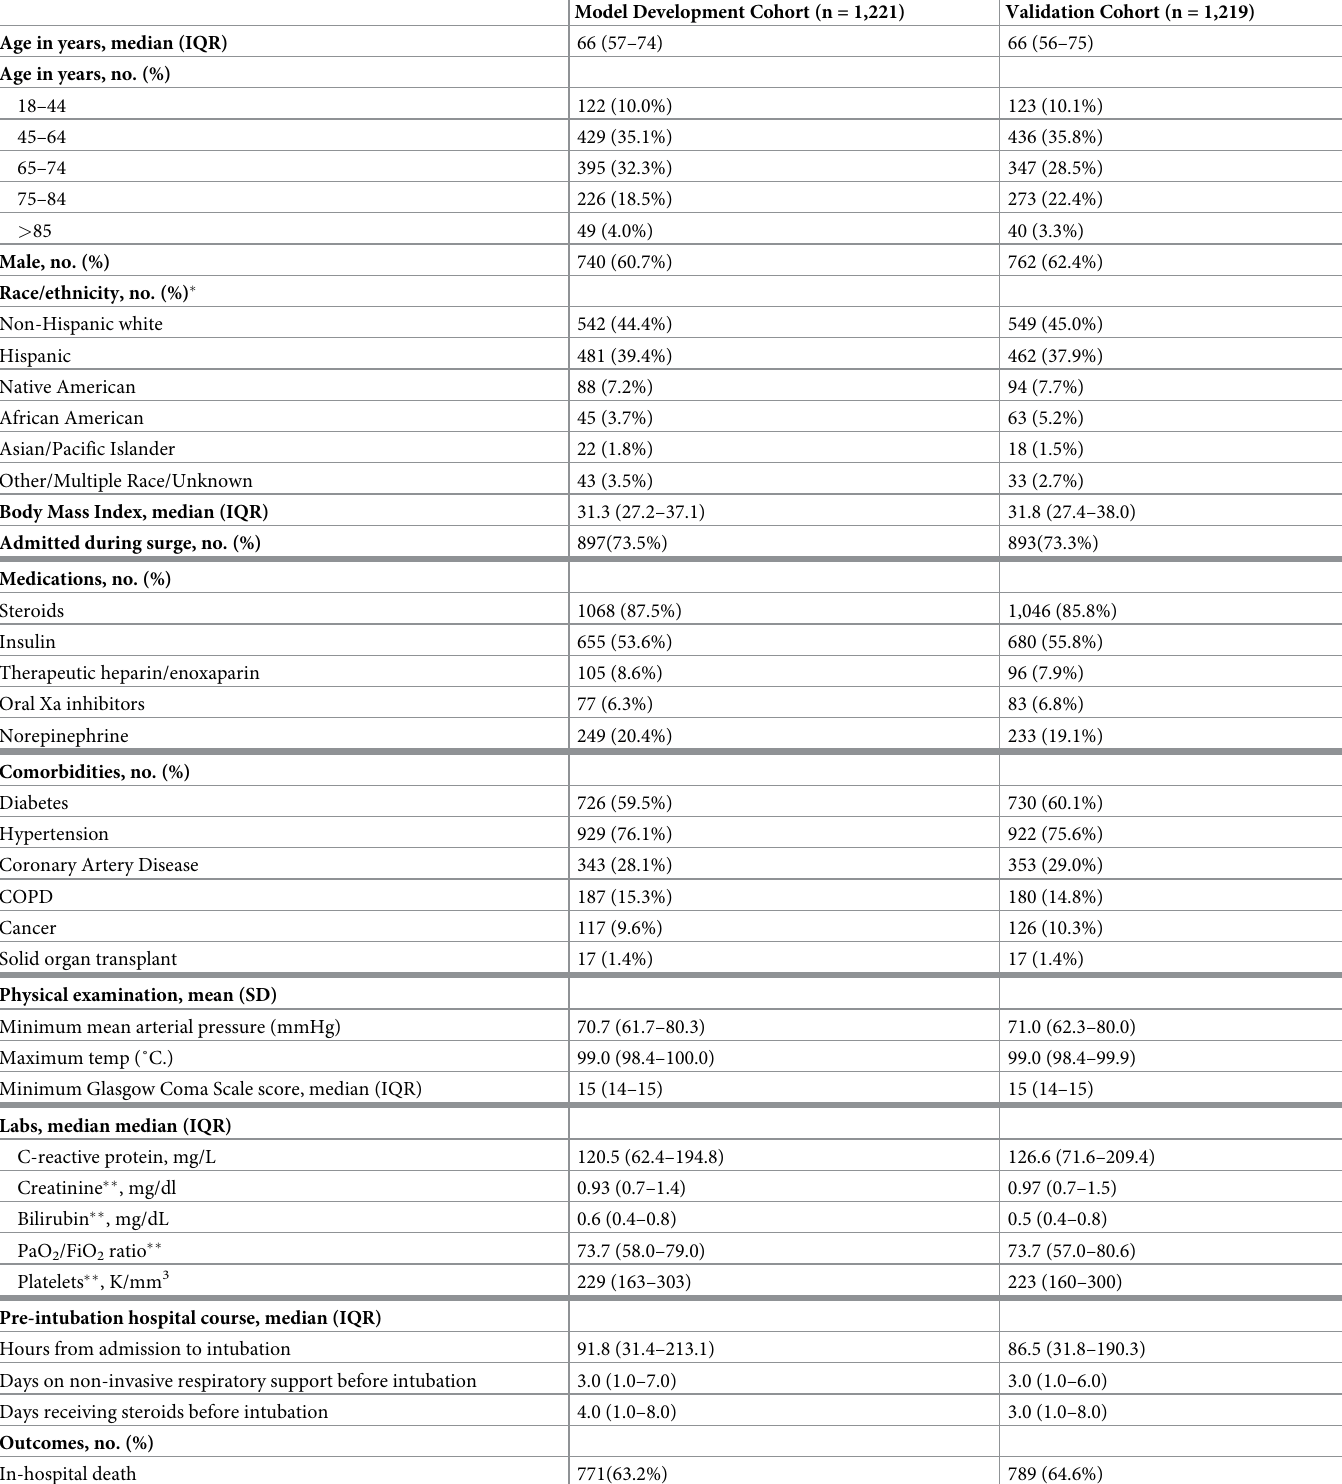
Table 1. Clinical characteristics of 2440 study